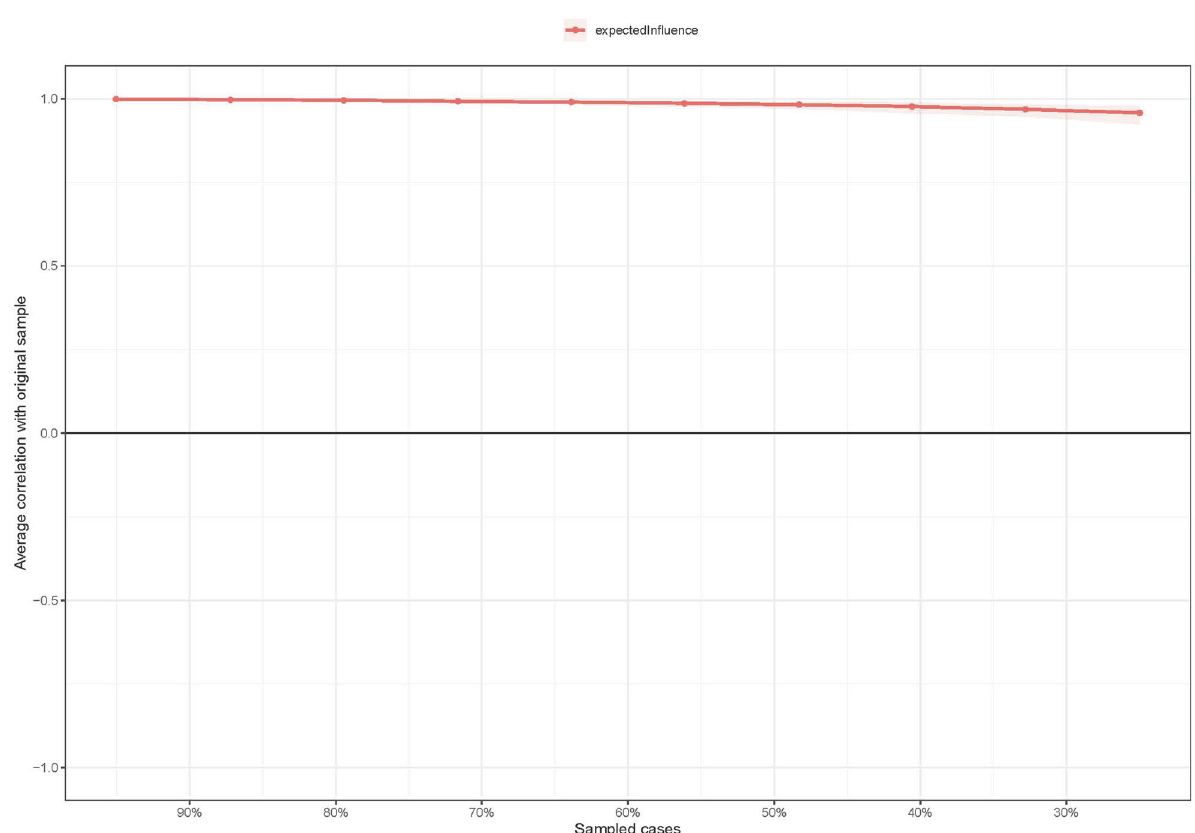
Fig. 5 The stability of centrality indice using case-dropping bootstrap. The x -axis represents the percentage of cases of the original sample used at each step. The y-axis represents the average of correlations between the centrality indices in the original network and the centrality indices from the re-estimated networks after excluding increasing percentages of cases. The red line indicates the Expected In fl